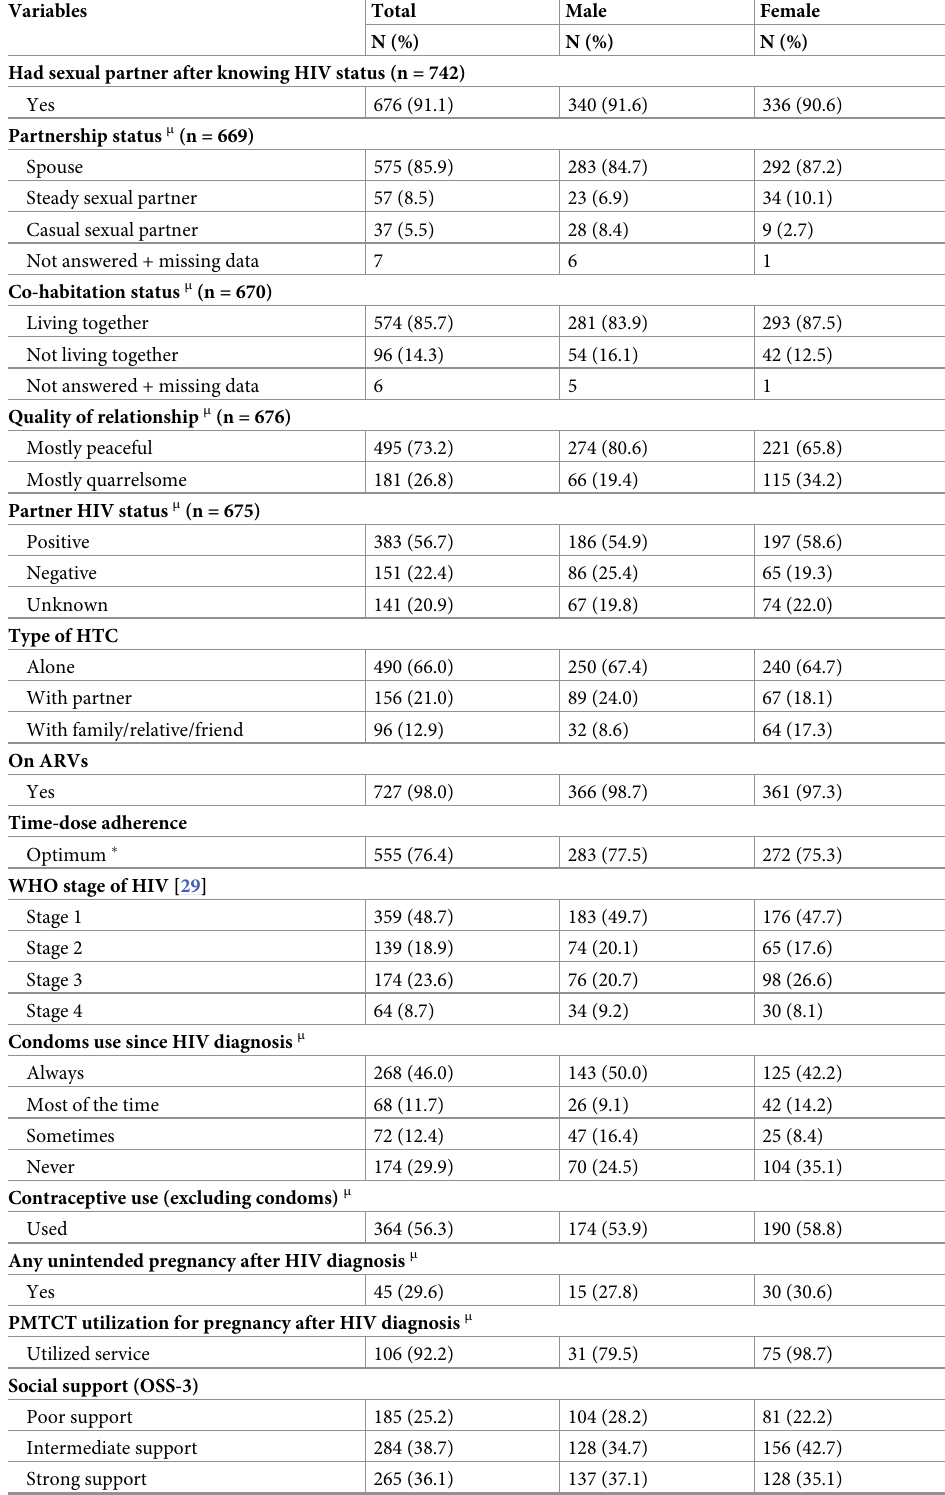
Table 2. Partnership, medical, and psycho-social characteristics of participants, by